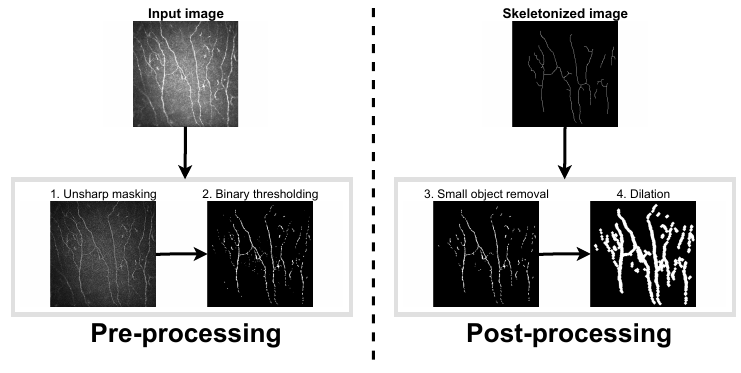
Figure 2. Scheme of the nerve tracing process.